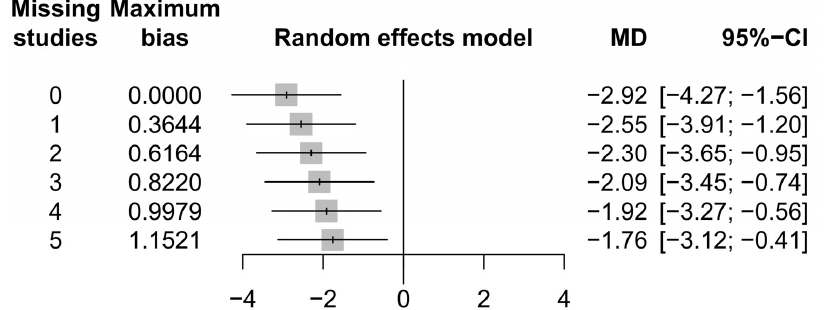
Figure 6. Sensitivity analysis for outcome reporting bias: stone expulsion time. CI, confidence interval; MD, mean difference.